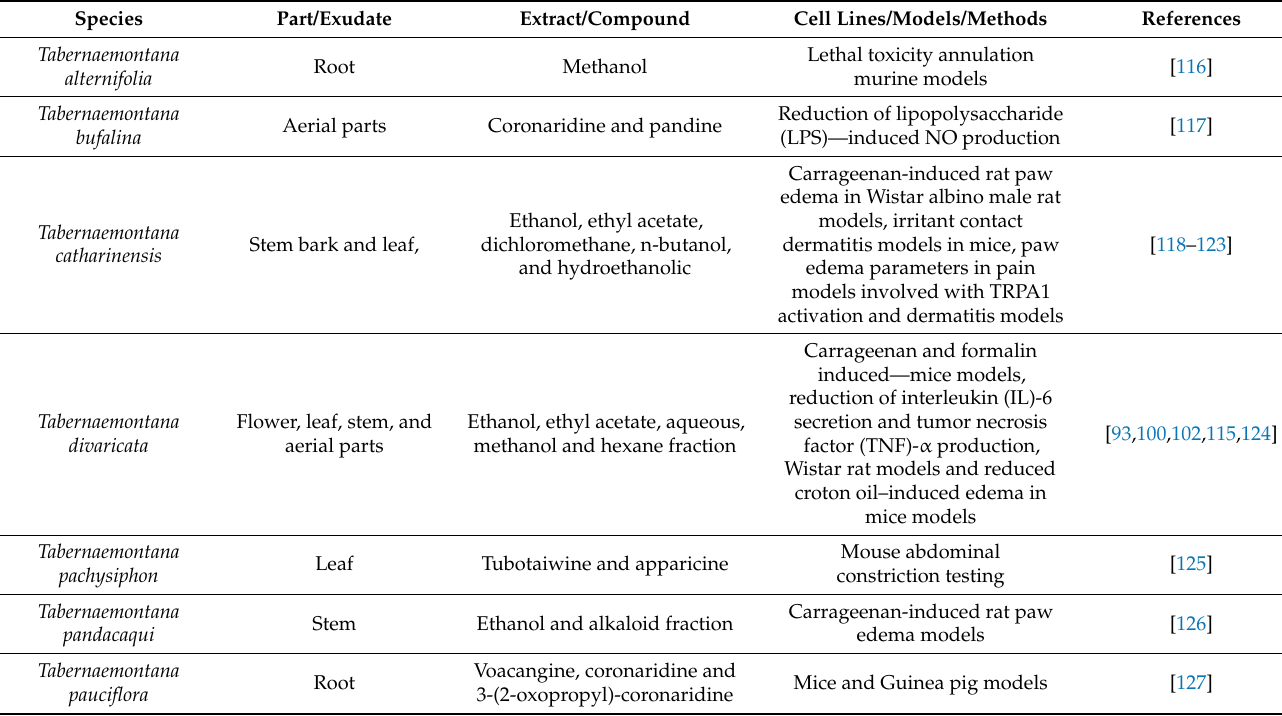
Table 3. Anti-inflammatory activities of extracts and compounds isolated from Tabernaemontana